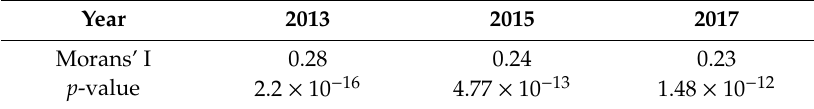
Table 14. Morans’ I of China prefecture-level population.